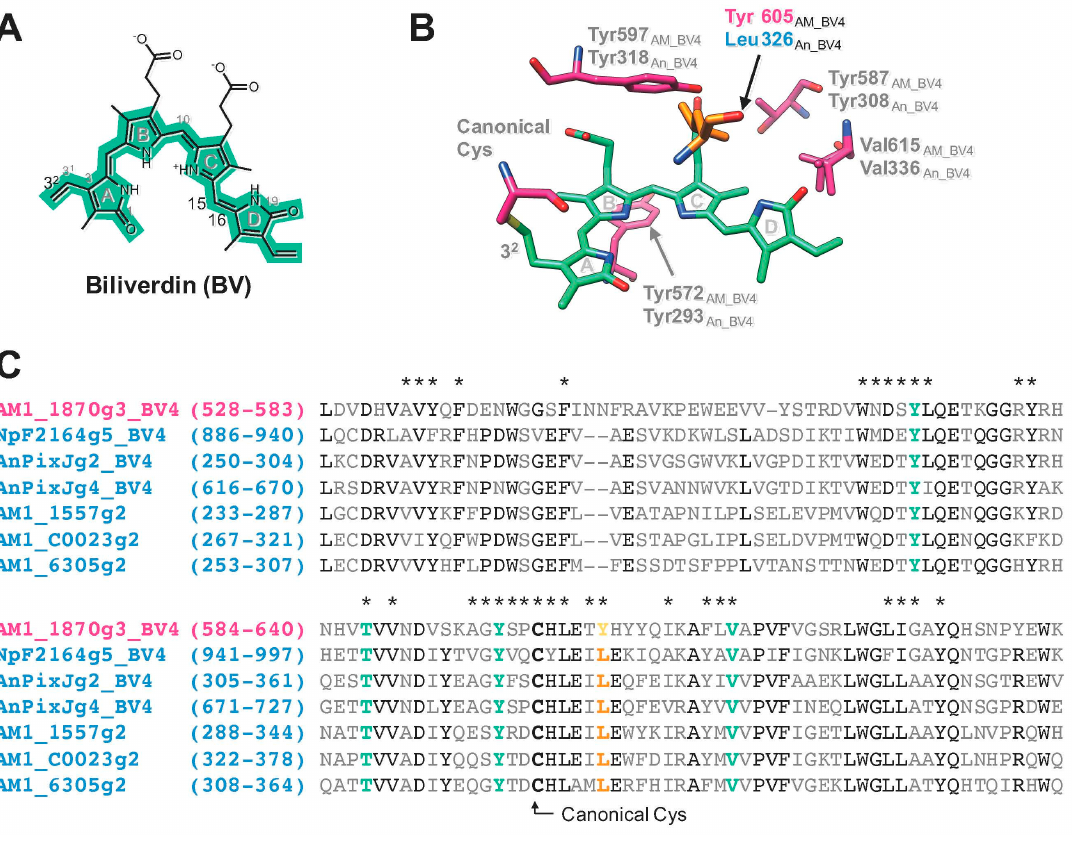
Figure 1. In silico analysis of the XRG CBCR GAF domain possessing BV4 residues. ( A ) Chemical structure of biliverdin (BV). The C3 2 position on a side chain of BV is covalently bound to a conserved canonical Cys residue within the expanded red / green (XRG) CBCR GAF domains having BV4 residues. Z / E isomerization of a double bond between the C15 and C16 positions occurs during the photoconversion or dark reversion of their domains. Generally, linear tetrapyrrole pigments (or bilin pigments) incorporated into CBCR GAF domains form Z –isomer in dark states (or ground state) and E –isomer in the photoproduct states (or excited state). ( B ) The crystal structure of the Pfr form of AnPixJg2_BV4 containing BV (PDB ID: 5ZOH) [25]. Tyr / Leu position is important for spectral tuning (orange), BV4 residues, and canonical Cys (deep pink) with BV (light green) are shown as a stick model. The subscripts, AM_BV4 and An_BV4 on each amino acid number, mean amino acid residues of AM1_1870g3_BV4 and AnPixJg2_BV4, respectively. ( C ) Sequence comparison between AM1_1870g3_BV4 (red-shifted XRG CBCR GAF domain, magenta) and the other XRG CBCR GAF domains having BV4 residues (cyan). Tyr / Leu position, orange; BV4 residues, light green; highly conserved residues, black. Asterisks are shown as amino acid residues within 6 Å of the